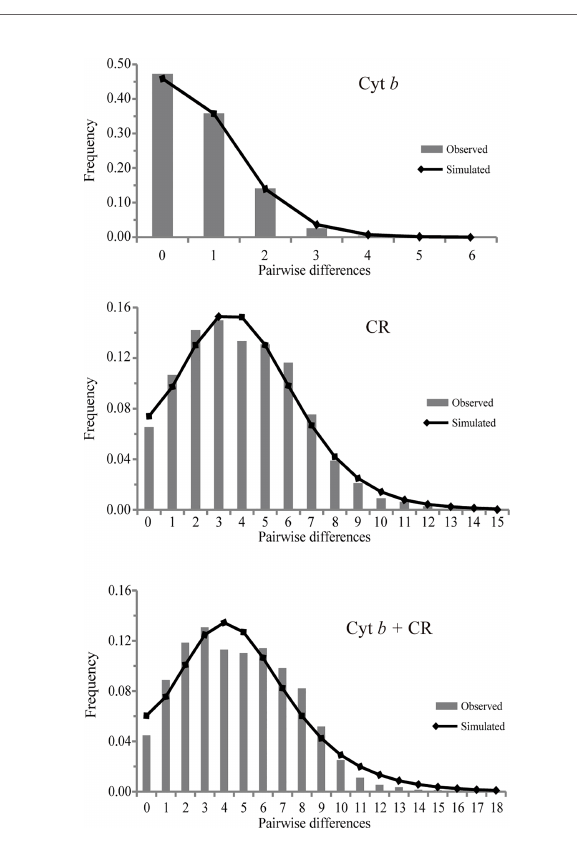
FIGURE 4 | Mismatch distribution for the pooled population of D. maruadsi based on Cyt b , CR, and concatenated sequences (Cyt b +